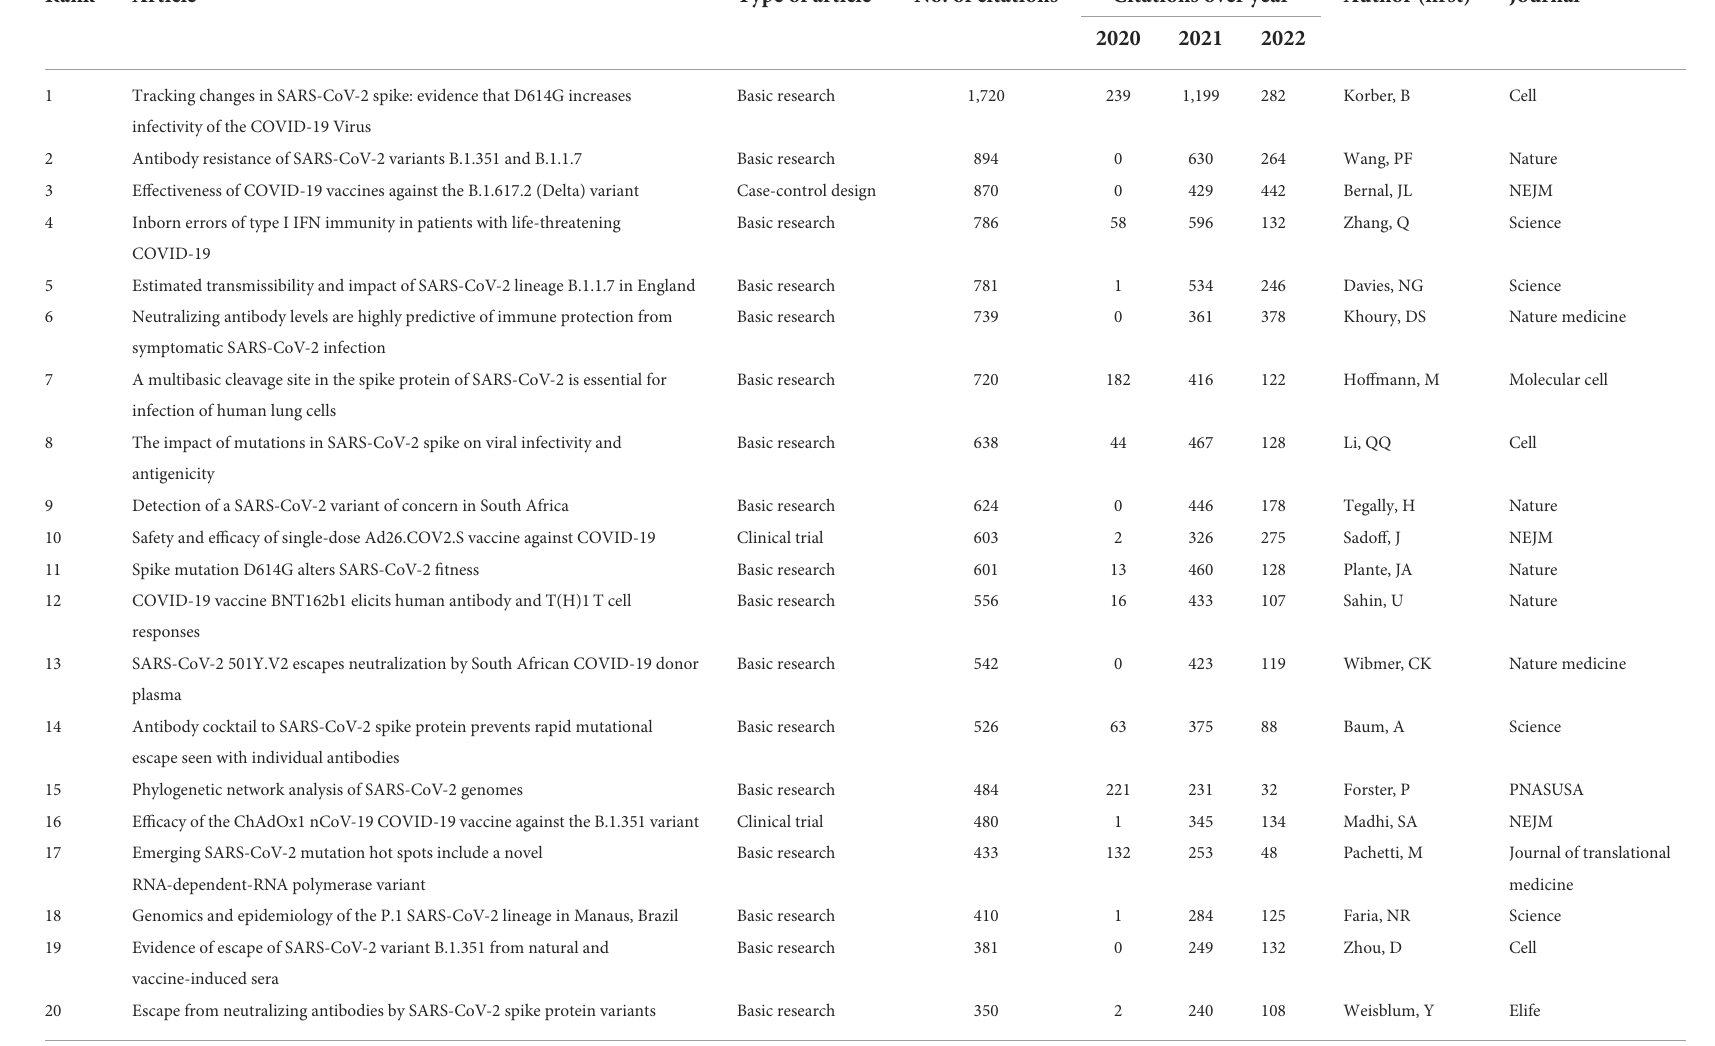
TABLE 3 The 20 most-cited SARS-CoV-2 variant articles ranked in order of the number of citations received.